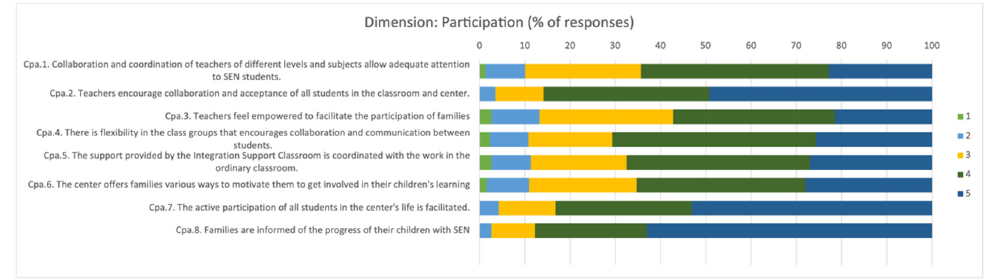
Figure 2. Percentage of responses about teachers’ opinions on the degree of participation in the ed- ucational community in the educational process. 1: Never; 2: Rarely; 3: Occasionally; 4: Almost al- ways; 5: Always.